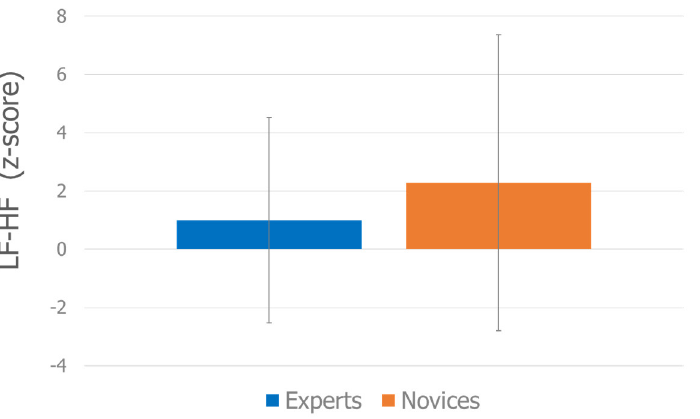
Figure 5. Median LF–HF values of the Experts (blue bar) and Novices (orange bar) across the entire flight simulation. No statistical difference ( p = 0.6) was found between the two groups.